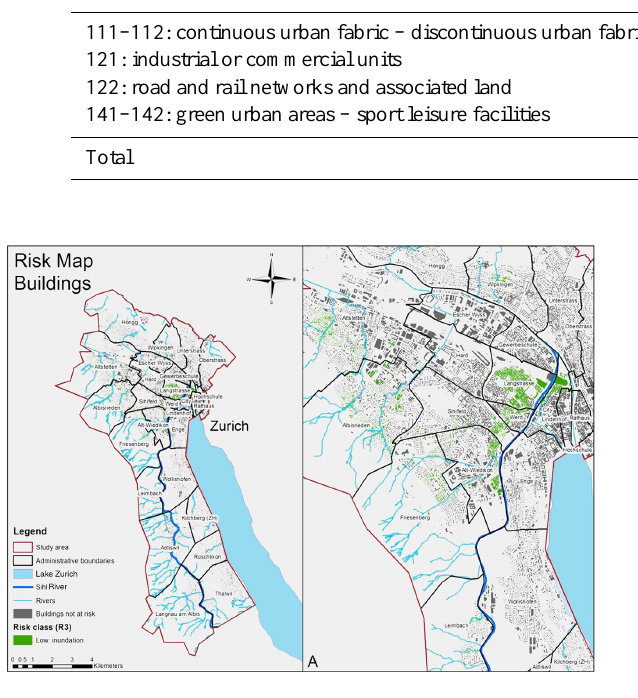
Figure 6. Relative risk map of buildings (left) and the city centre (right). Table 11. Relative risk classes and range of values for